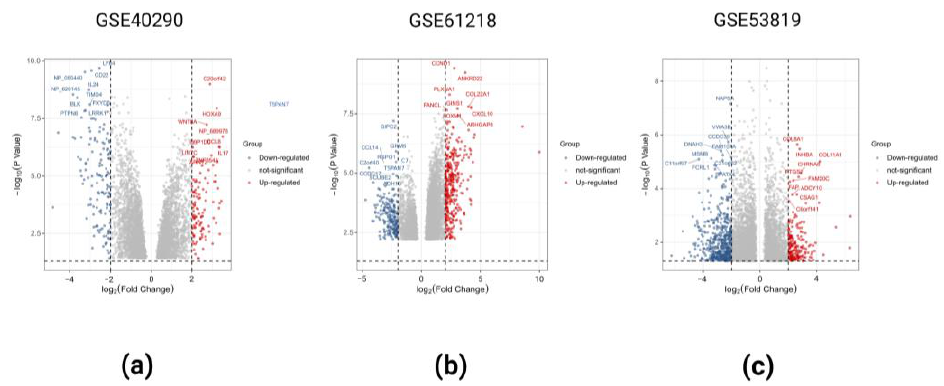
Figure 1. Volcano maps of DEGs in GSE40290 ( a ), GSE61218 ( b ), and GSE53819 ( c ).